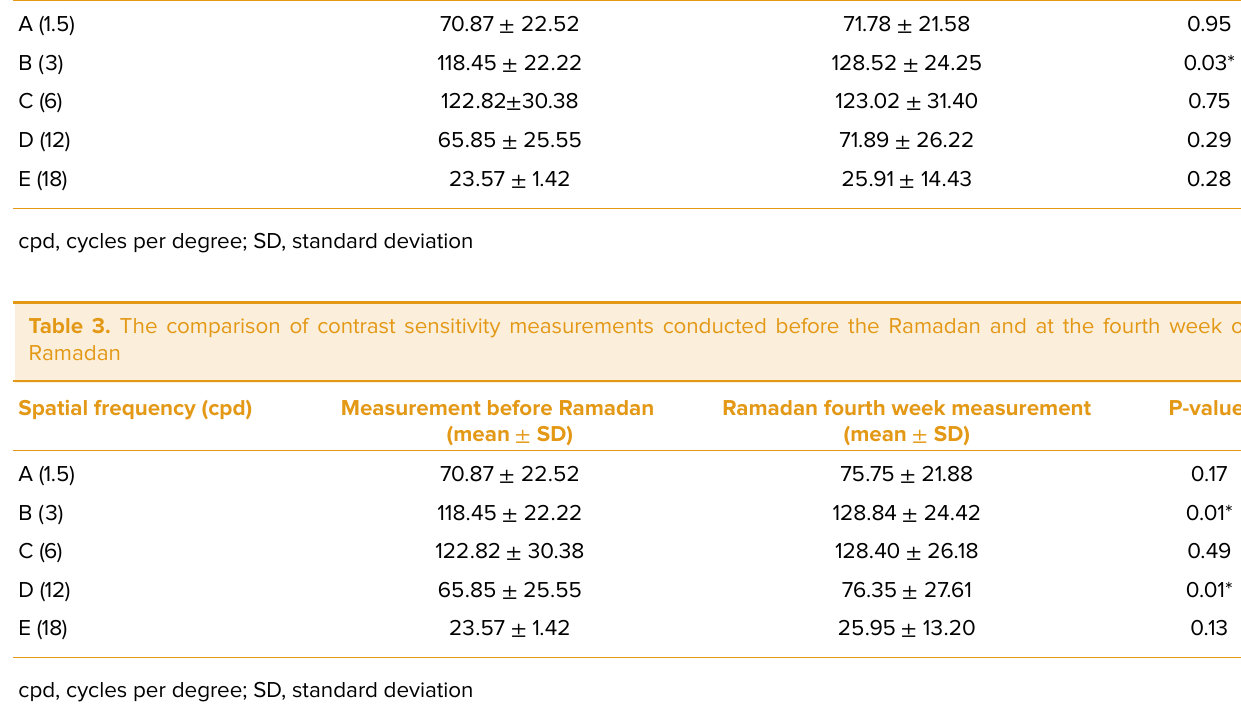
Table 2. The comparison of contrast sensitivity measurements conducted before the Ramadan and in the first week Spatial frequency (cpd)